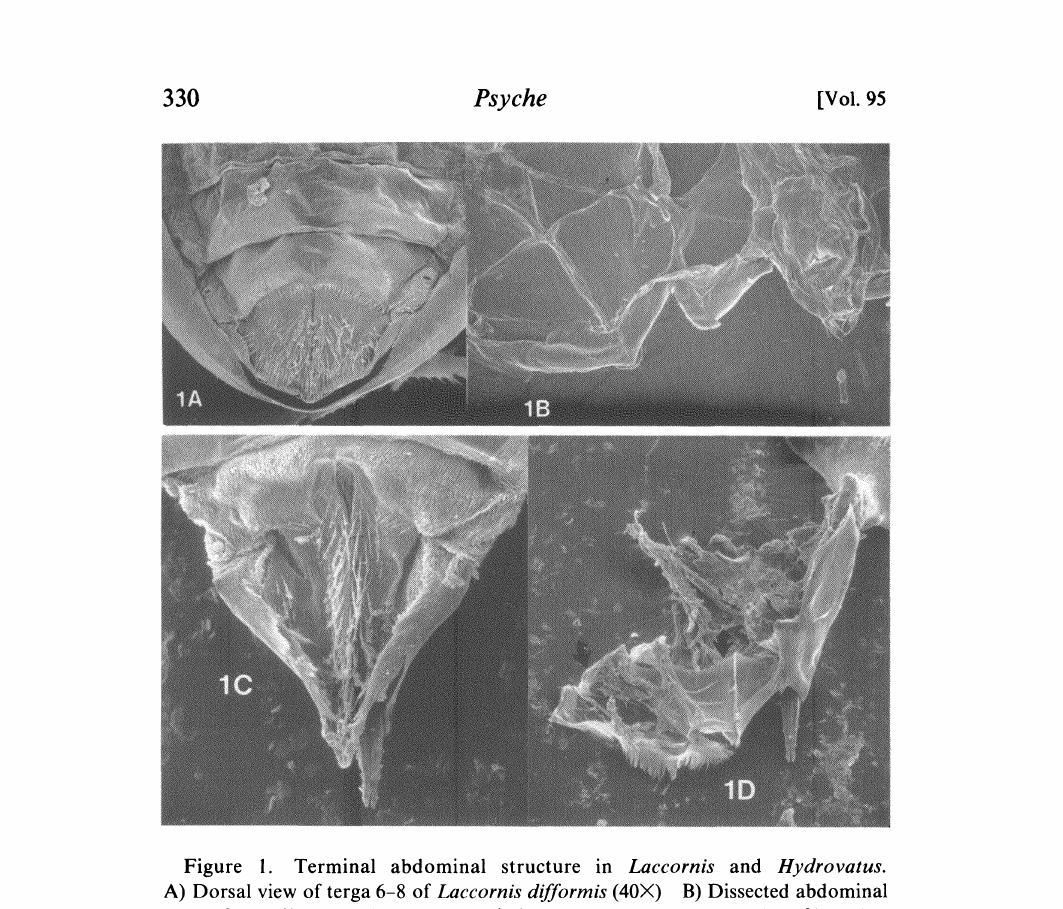
Figure 1. Terminal abdominal structure in Laccornis and Hydrovatus. A) Dorsal view of terga 6-8 of Lacornis difformis (40X) B) Dissected abdominal apex of L. difformis (40). Tergum 8 is folded back (all the way to the left) so that ventral surface is exposed revealing ventral fold (indicated by arrow); tergum 8 is not bilaminar. C) Acutely pointed eighth tergum of Hydrovatus pustulatus (80). D) Dissected abdominal apex of H. pustulatus. Tergum 8 is folded so that dorsal lamina (left arrow) is separated from ventral lamina (right arrow)